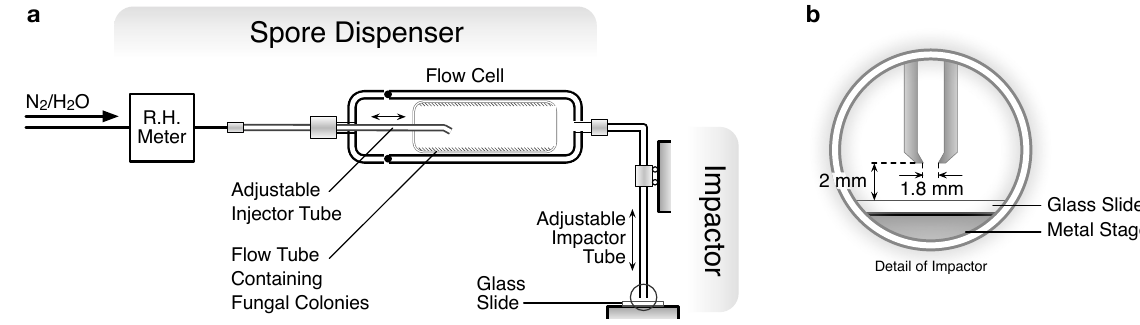
Fig. 3. Schematics for the collection of fungal spores using a spore dispenser and an impactor. Panel (a) depicts the arrangement of the